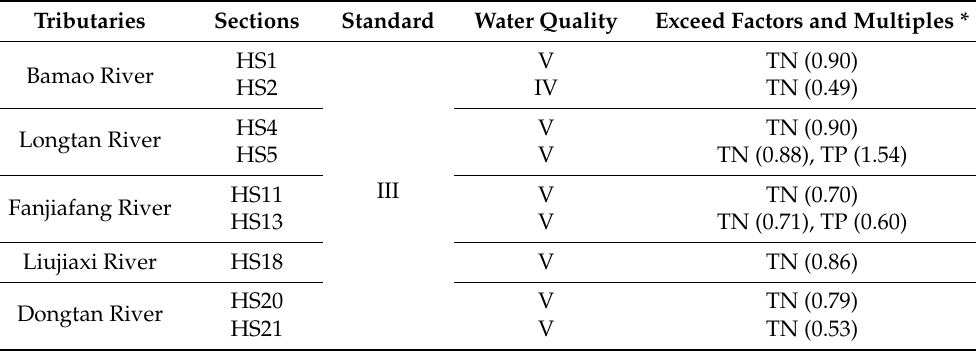
Table 4. The water quality evaluation result of the tributaries.